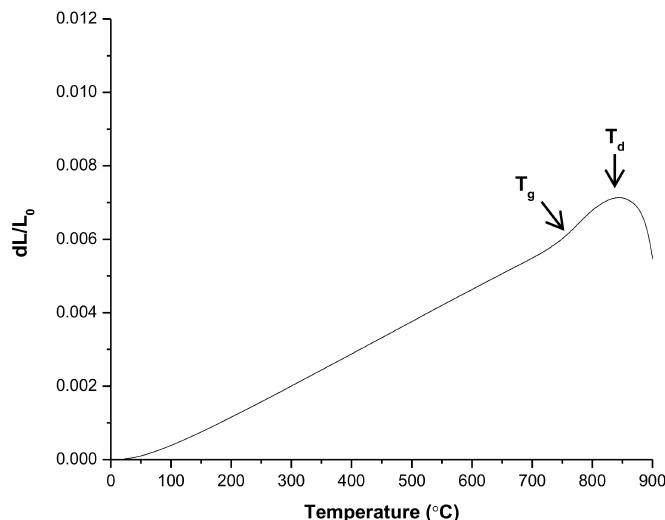
Figure 10. Dilatometric thermal expansion curve on heating for the volcanic ash glass at a heating rate of 5 ◦ C / min in air. Glass transition temperature ( T g ) and glass softening temperature ( T d ) are indicated. Table 5. Thermal and mechanical properties of volcanic ash, synthetic sand, and desert sand glasses. Property Volcanic Ash Glass Synthetic Sand Glass * Desert Sand Glass ± Melting ( T m , ◦ C)